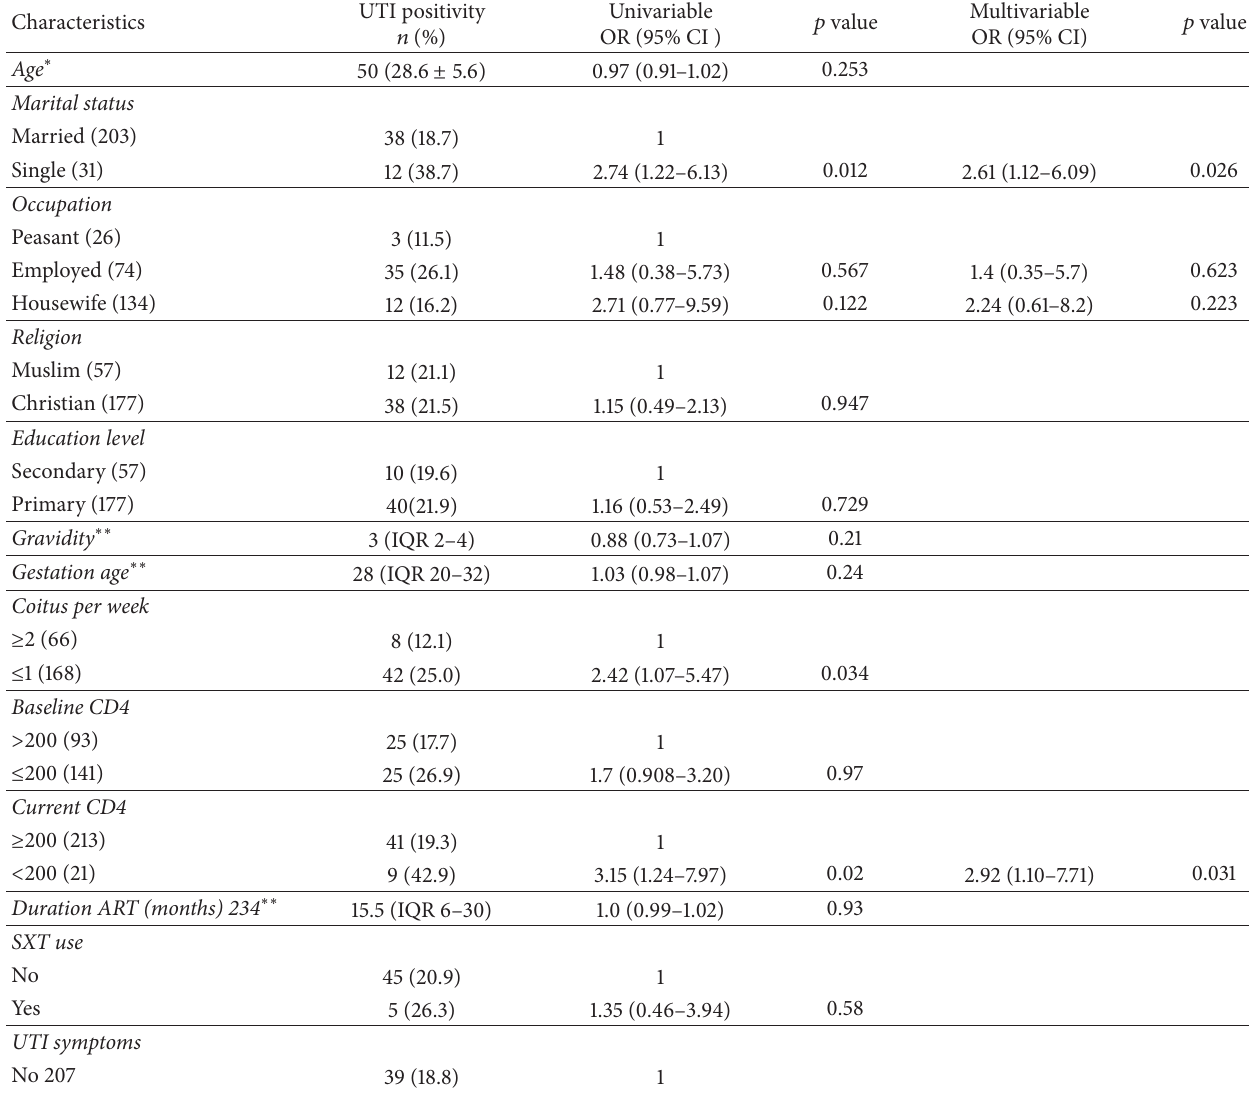
Table 4: Univariable and multivariable logistic regression analysis of the factors associated with UTI among HIV-infected pregnant women.